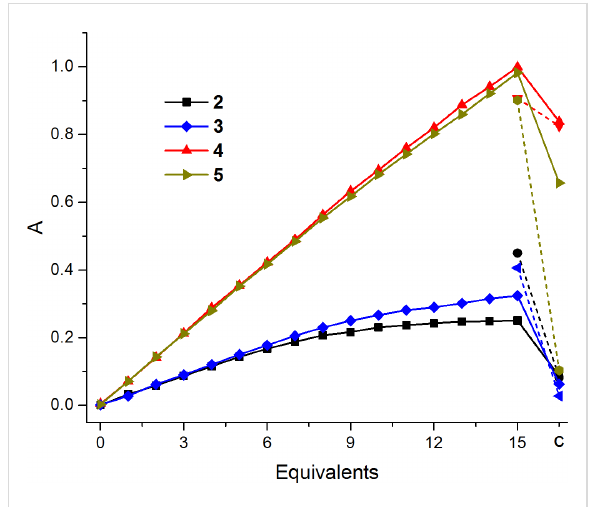
Figure 5: Absorption changes during titration of 2 and 4 ( λ = 344 nm) in the presence of (dA) 10 , and 3 and 5 ( λ = 364 nm) in the presence of T 10 (1.25 μ M template, 15 equiv = 18.8 μ M) in H 2 O. After complete titration, the unbound chromophores precipitated due to their insolu-